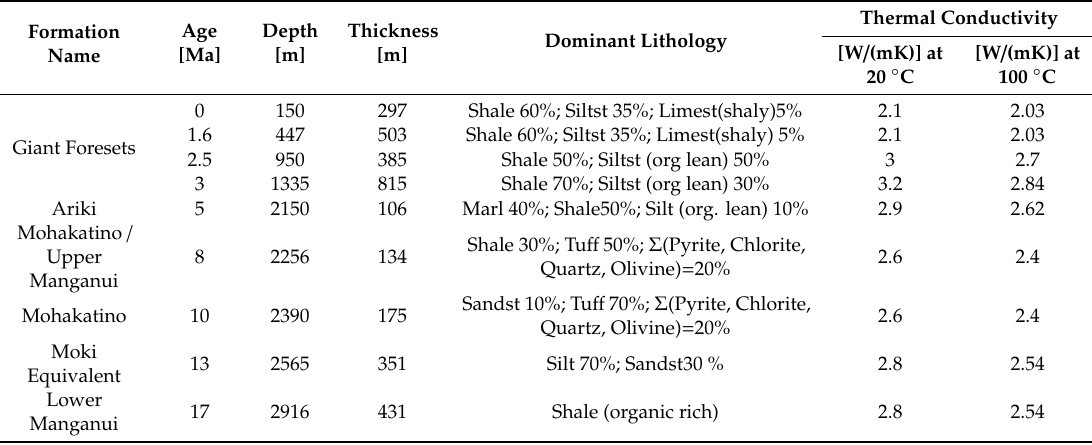
Table 2. Summary of lithostratigraphy intersected by Ariki-1 well in the northern Taranaki Basin.